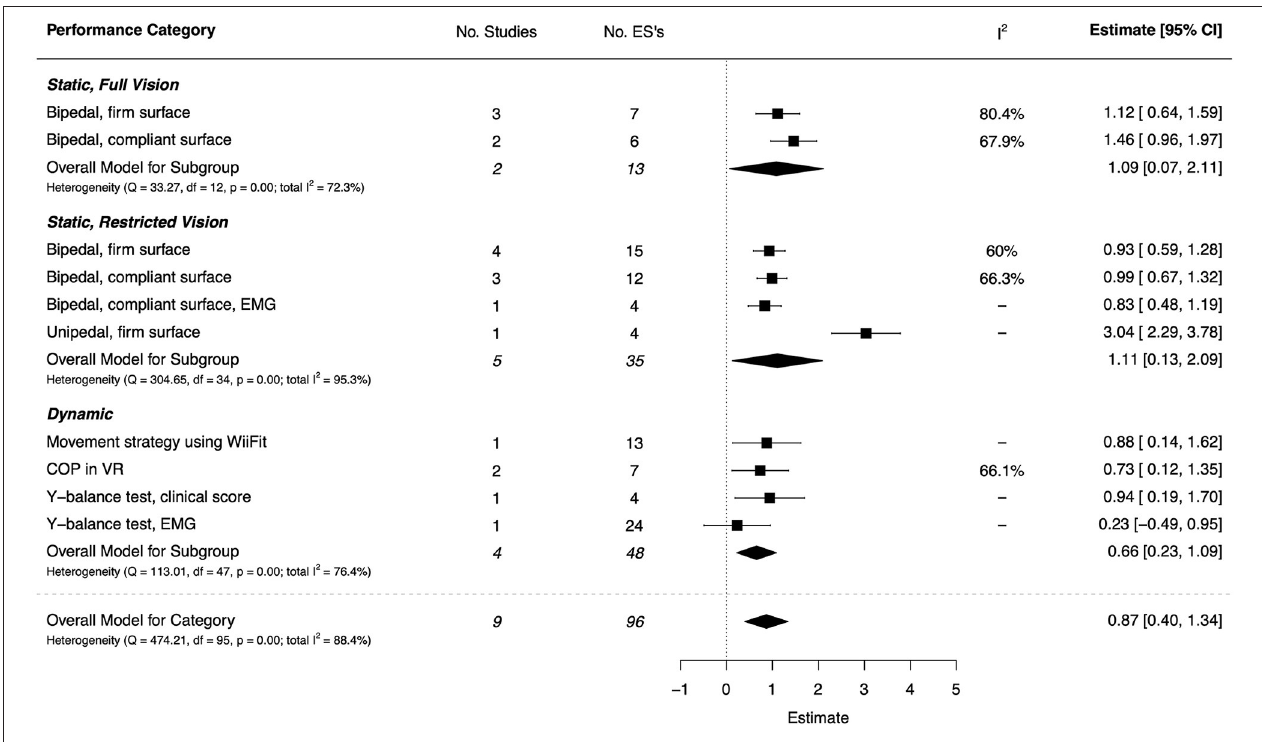
FIGURE 12 | Forest plot showing the meta-analysis results for the postural control performance category. EMG, Electromyography; COP, Center-of-Pressure; VR, Virtual Reality.